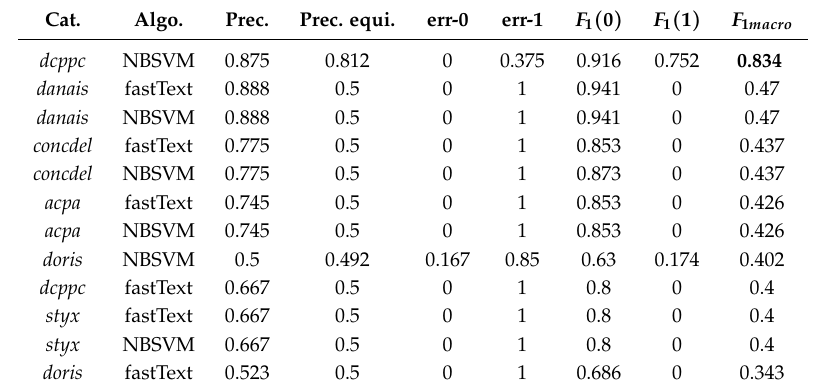
Table 9. Evaluation of fastText and NBSVM for detecting judicial outcomes for each claim category.